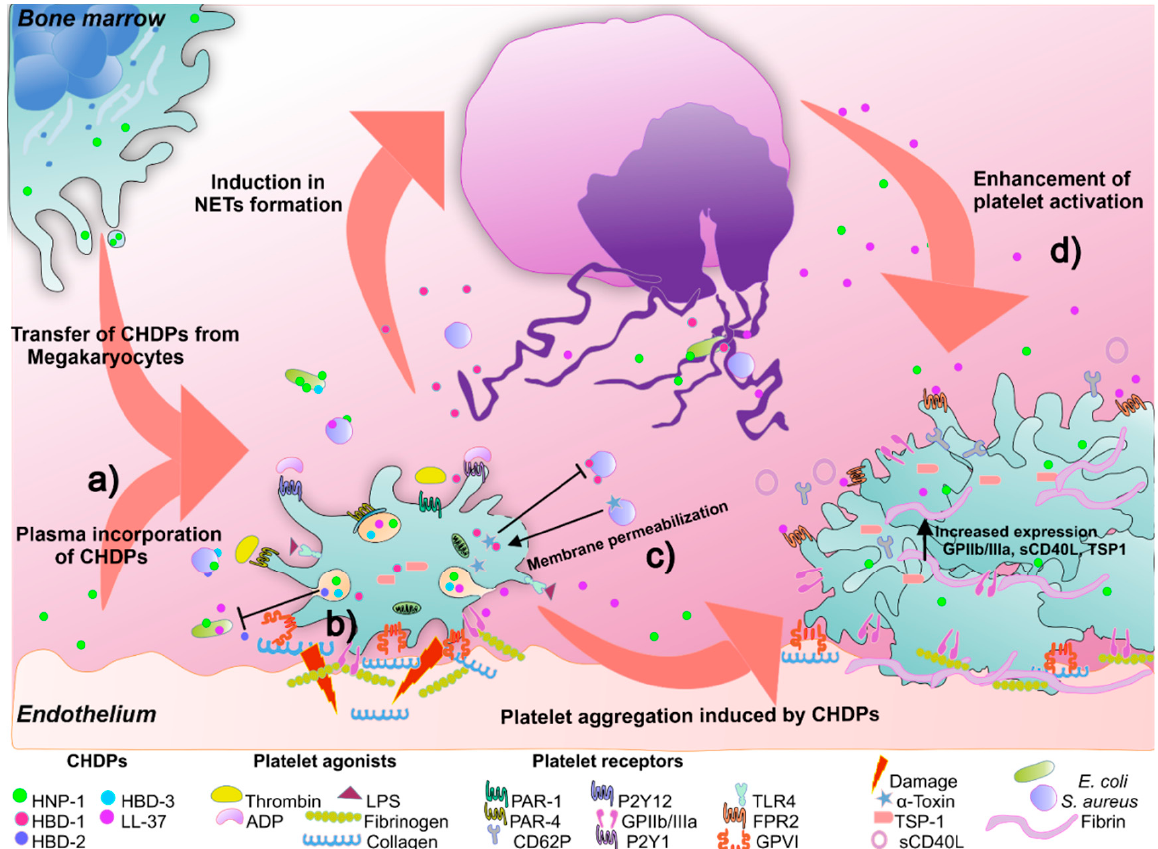
Figure 4. Platelet immune and hemostatic functions through cationic host defense peptides (CHDPs). ( a ) Platelet CHDPs arise as part of the arsenal inherited by their precursor cells or from extracellular uptake from plasma. ( b ) Some CHDPs are stored within granules and are released upon recognizing activation-inducing components exposed during vascular damage (collagen, thrombin, and ADP) or by the presence of microbial components (lipopolysaccharide). Taken together, platelet CHDPs are capable of eliminating a great diversity of pathogens. ( c ) Platelets contain HBD1 in their cytoplasm, and the presence of permeabilizing agents on the bacterial membrane (e.g., α -toxin) induces its release. HBD1 released by platelets kills bacteria directly or through NETs induction. ( d ) CHDPs of platelet originated or produced by other cells increase platelet activation (increased CD62P, GPIIb/IIIa surface expression, or TSP-1 and CD40L secretion), particularly for LL-37, through recognizing FPR2 receptor. Human neutrophil peptide-1 (HNP-1), human beta defensin 1-3 (HBD1-3), adenosine diphosphate (ADP), protease-activated receptors-1, -4 (PAR-1, -4), thrombospondin (TSP-1).